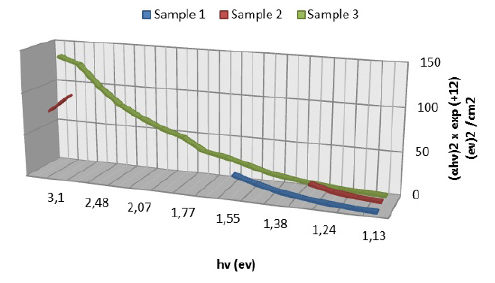
Figure 6. Plot of ( αhν ) 2 vs. photon energy ( hν ) for three CuInSe 2 films The extinction coefficient ( k ) is determined from the fol- lowing equation [10]: